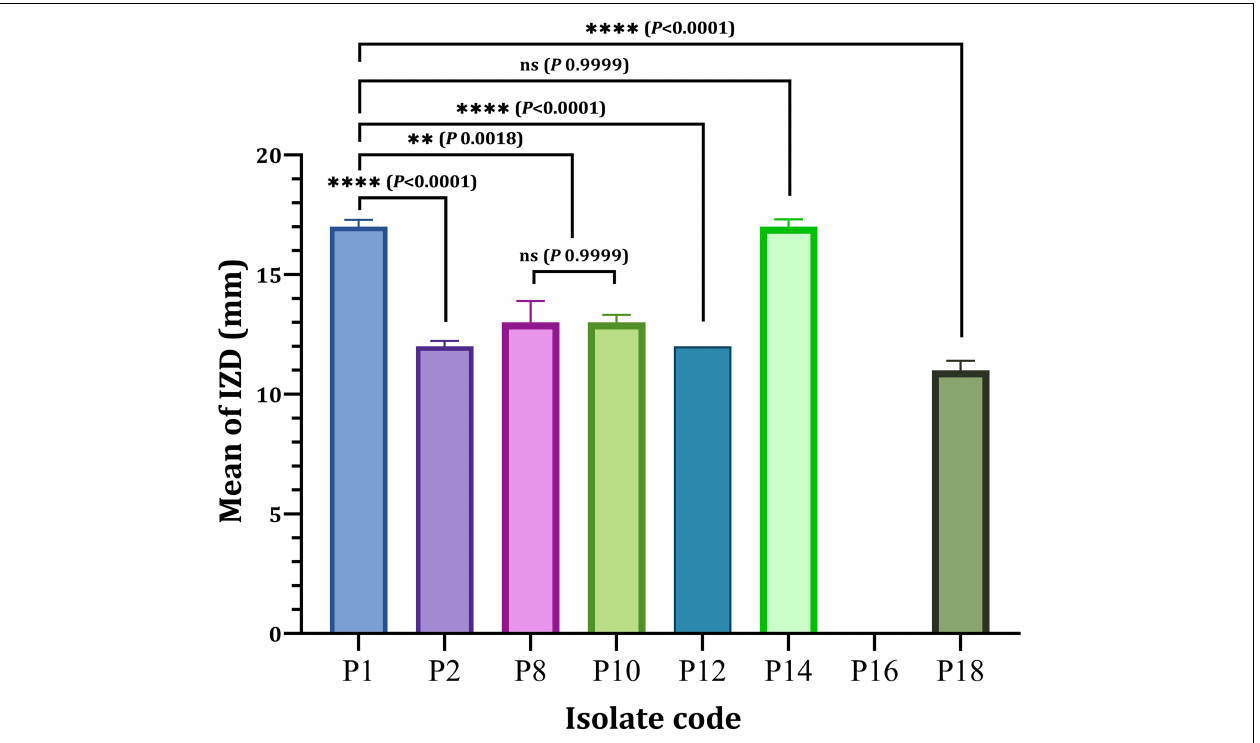
FIGURE 3 | Antibacterial activity of Ag-NPs against selected P. aeruginosa isolates. IZD, inhibition zone diameter (mm); ns, non-significant. ** P < 0.01, **** P < 0.0001 and P -value ≤ 0.05 is significant.